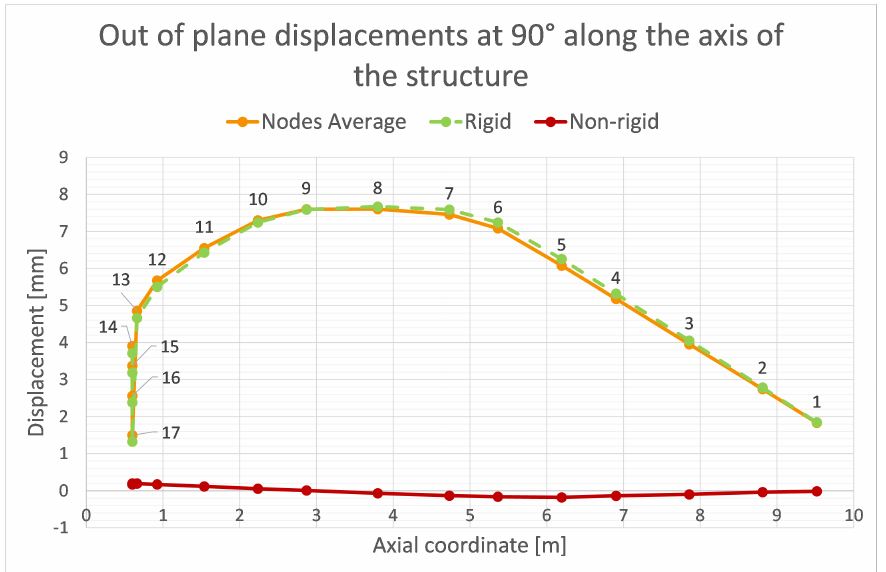
Figure 5. Components of the out-of-plane displacement when the structure is at 90°: NAD in (orange), theoretical rigid displacement (dashed green) derived from the interpolation of NAD with respect to the r coordinate, non-rigid displacement obtained by subtracting the rigid component from NAD (dark red).